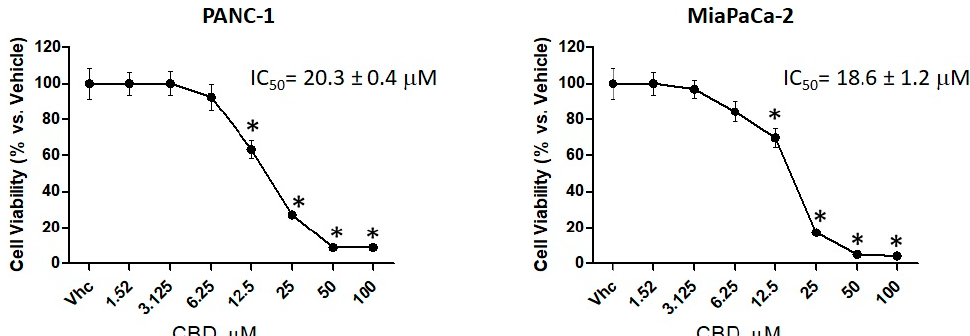
Figure 1. Cannabidiol (CBD) induced cytotoxicity in PDAC cell lines. Cell viability was determined